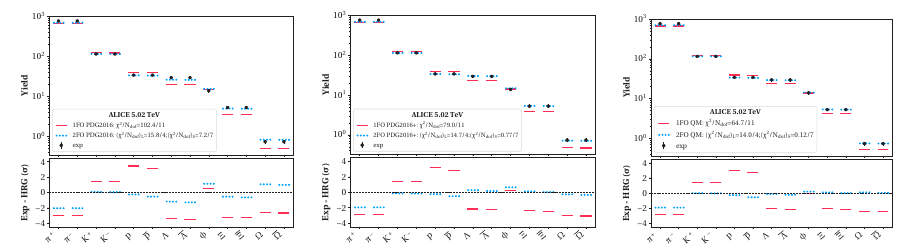
10% collisions, in comparison −